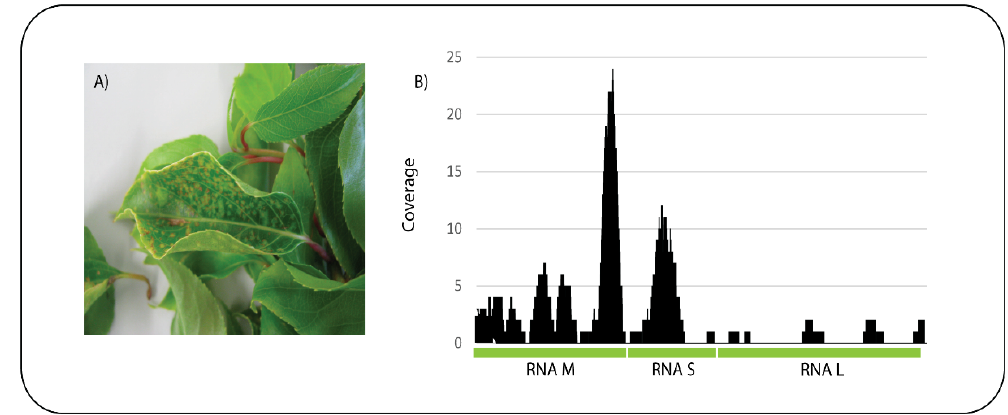
Figure 4. Actinidia showing symptoms of chlorotic and necrotic spots on the leaves ( A ) and sequence reads from the sample mapped to the three concatenated genome segments (RNA M, S and L) of tomato spotted wilt virus ( B ).